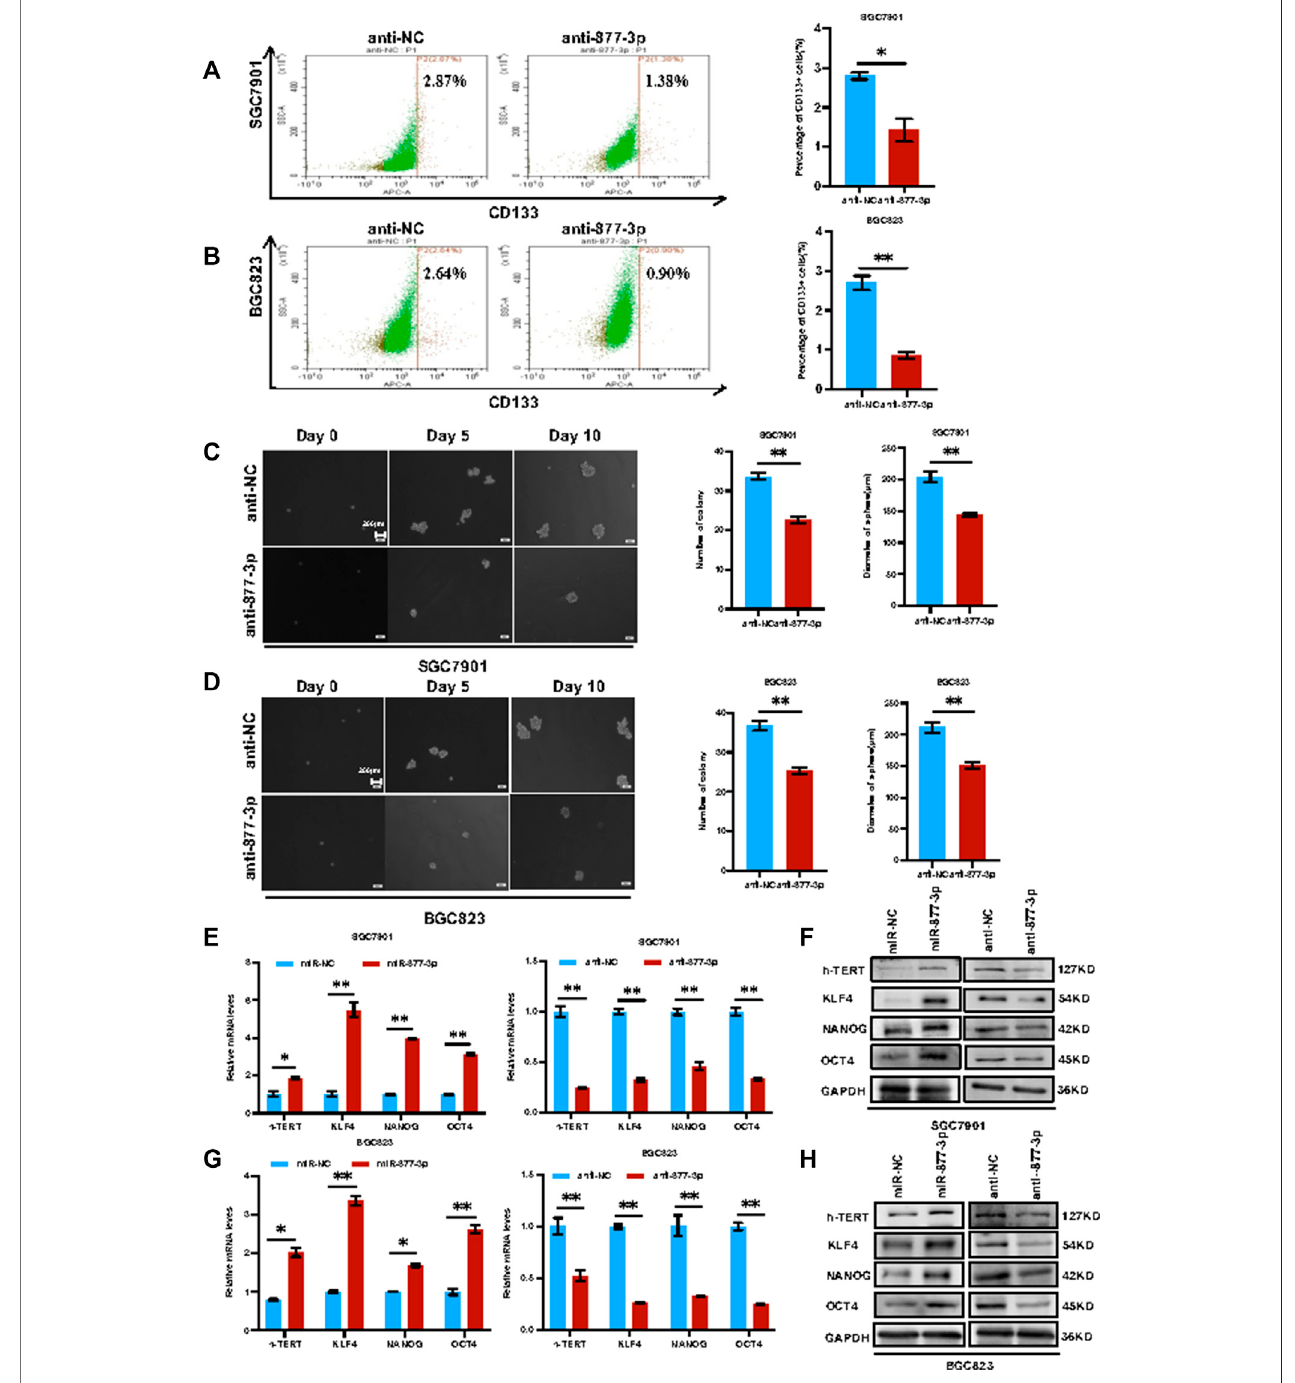
FIGURE 4 | Knockdown of miR-877-3p suppressed gastric cancer cell stemness. (A,B) : Knockdown of miR-877-3p in SGC7901 and BGC823 cells suppressed thesubpopulationofCD133 + CSCs. (C,D) :Knockdownof miR-877-3p inSGC7901andBGC823cellssuppressedthesphereformationabilityintheserum-freeculture condition. (E,F) : QRT-PCR (E) and western blot (F) analyses of the stemness genes including h-Tert , Klf4 , Nanog and Oct4 in SGC7901 cells with or without overexpression or knockdown of miR-877-3p . (G,H) : QRT-PCR (G) and western blot (H) analyses of the stemness genes in BGC823 cells with or without overexpression or knockdown of miR-877-3p . Data are presented as the mean ± SEM ( N = 3). * p < 0.05, ** p < 0.01, *** p < 0.001.